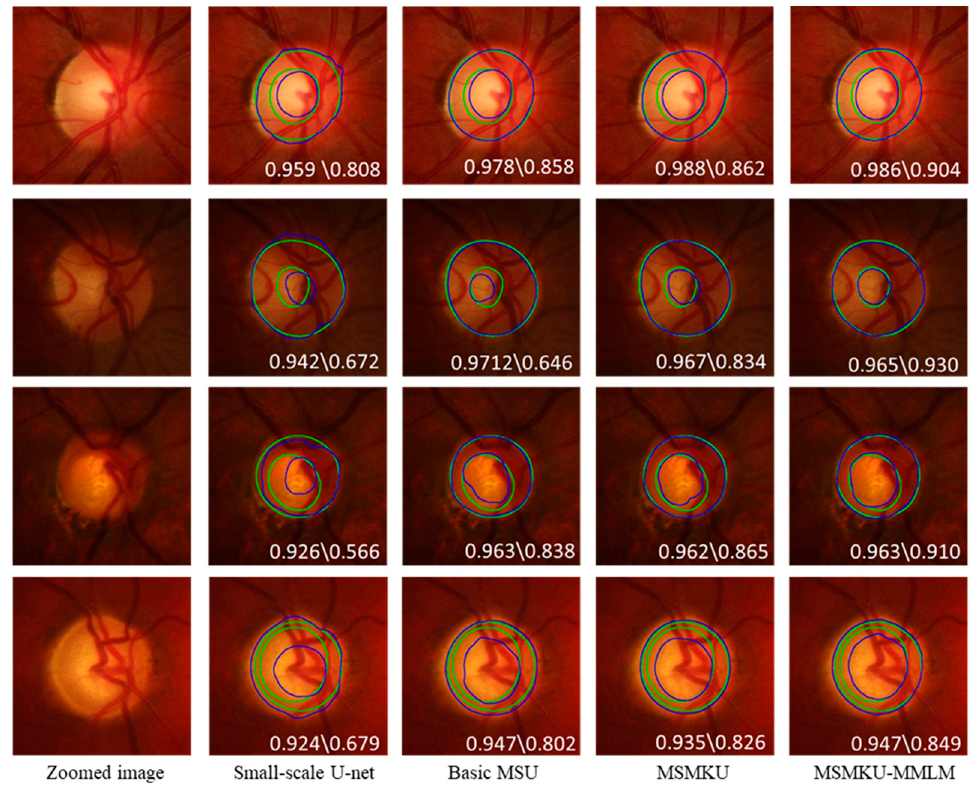
Figure 7. Examples of the OD and OC segmentation by different methods. From the first to fifth column, the examples are zoomed image segmentation results by small-scale U-Net, basic MSU, multi-scale input and multi-kernel modules (MSMKU) and MSMKU–maximum loss minimization learning strategy (MMLM), respectively. The green contours refer to the ground truth, while the blue ones indicate the results of the different segmentation methods. The F-score of OD and OC is shown in each image: F-score of OD\ F-score of OC.